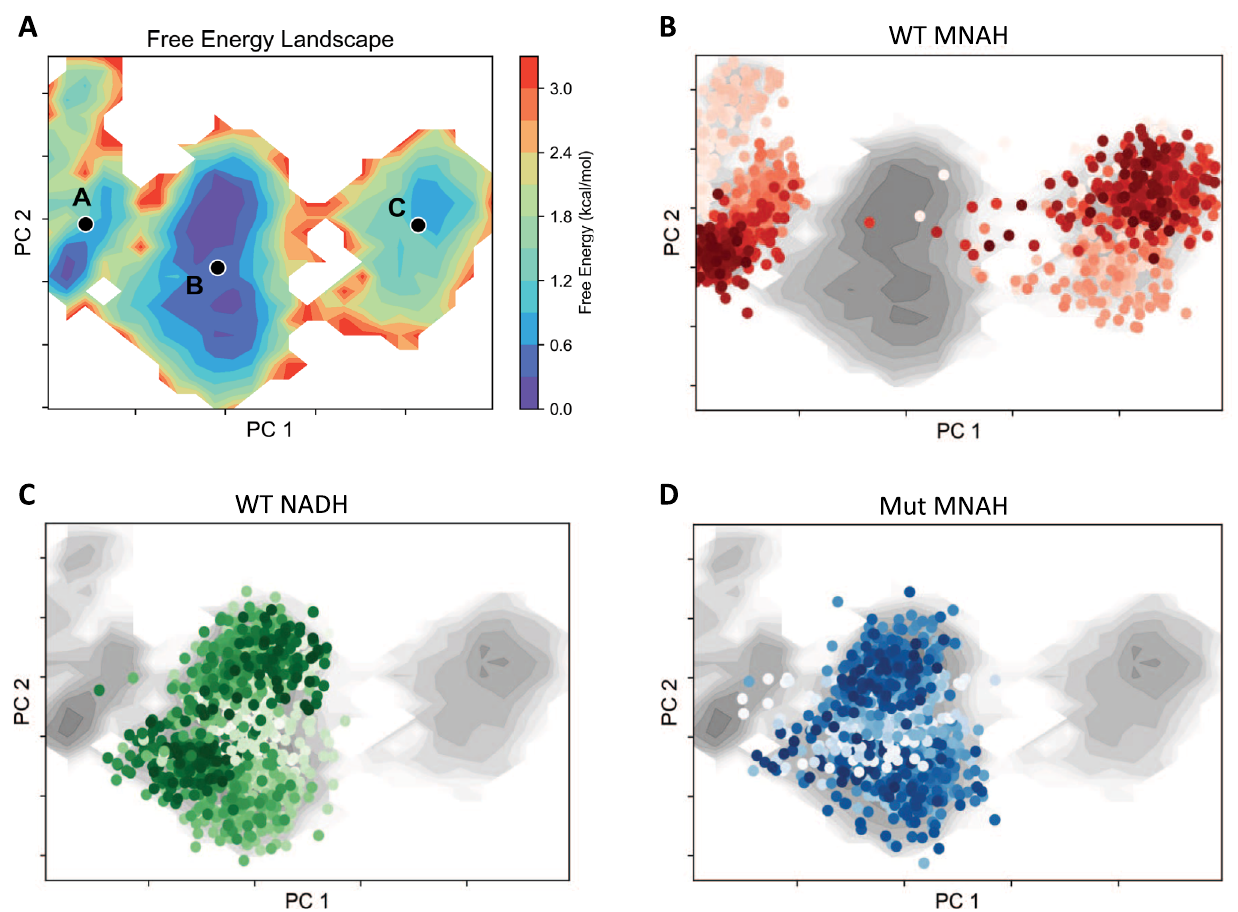
Fig. 7 | Comparison of conformational landscape of wild type and engineered Lp Nox. Global variation in backbone ensembles is represented by PCA dimen- sionality reduction of alpha carbon dihedrals, all samples are combined onto shared latent space and plotted on the fi rst two principal components. Color intensity in panels B, C, and D indicate temporality, with lighter colors signifying conformations at the start of the simulation, and darker colors marking samples near the end. A The combined free energy landscape shows grouping into three local minima, whose centers are labeled A, B, and C through K-Means clustering. B WT with MNAH samples disjoint regions of conformation space along the fi rst